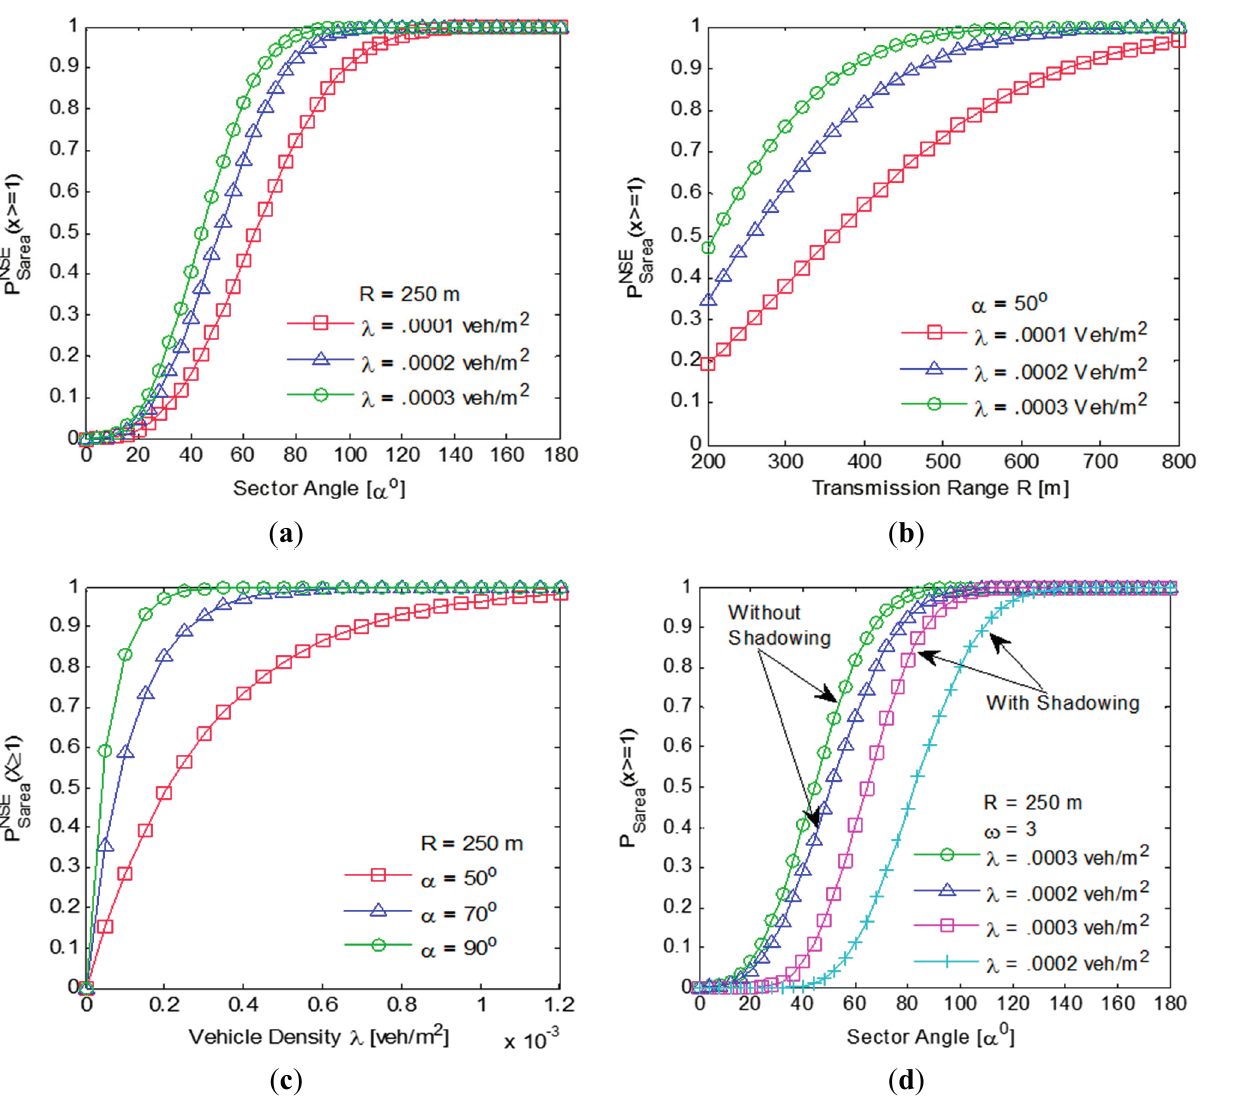
(cid:3020)(cid:3006) ((cid:1850) ≥ 1) (cid:3020) (cid:3276)(cid:3293)(cid:3280)(cid:3276)